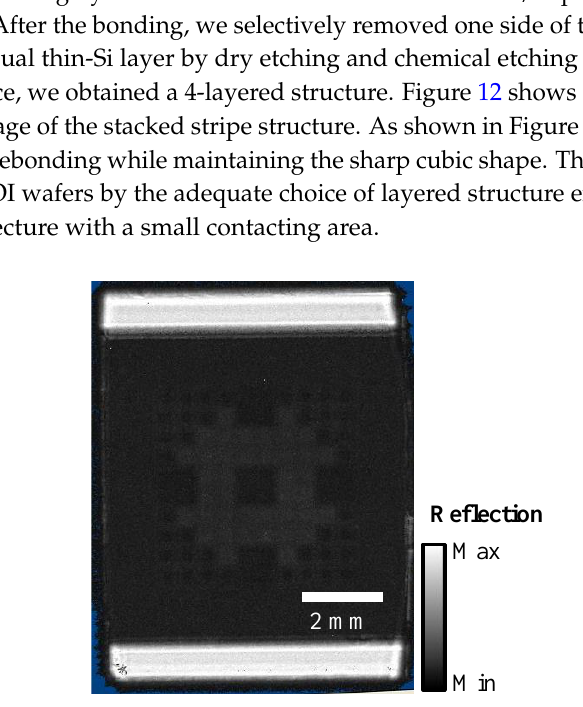
Figure 10. Observation of bonded interface with scanning acoustic microscope (SAM). Obtained imaging map for the bonding of a pair of SOI wafers A ( a ) and B ( b ).